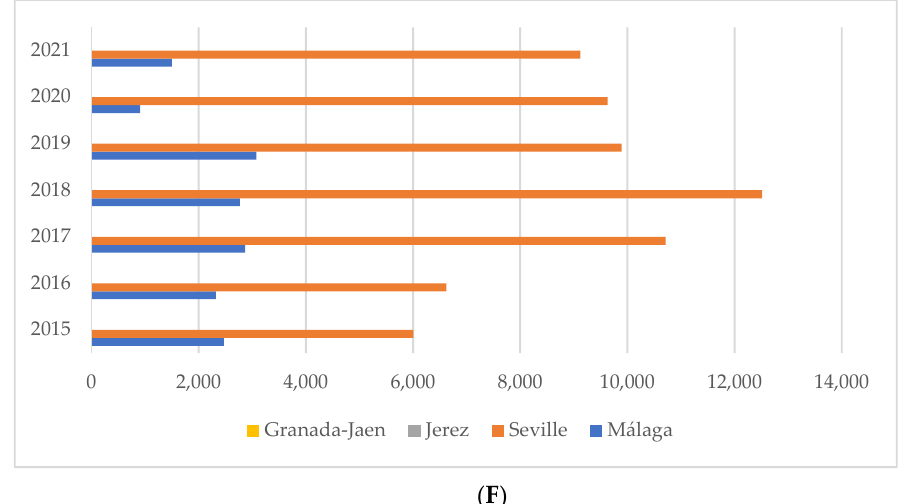
Figure 2. Passenger arrivals, aircraft movements, and air freight at UK and Spanish airports. ( A ) Passenger arrivals at four MAG airports; ( B ) Passenger arrivals at four AENA airports; ( C ) Aircraft movements at MAG airports; ( D ) Aircraft movements at AENA airports; ( E ) Air cargo at MAG airports (Tons); ( F ) Air cargo at AENA airports (Tons). Source. Own elaboration based on data MAG [111], CAA [112] and AENA [97]. Table 1. MAG passenger, aircraft, and cargo movements (2010–2021). Source. Own elaboration based on data MAG [111], CAA [112] and AENA [97].